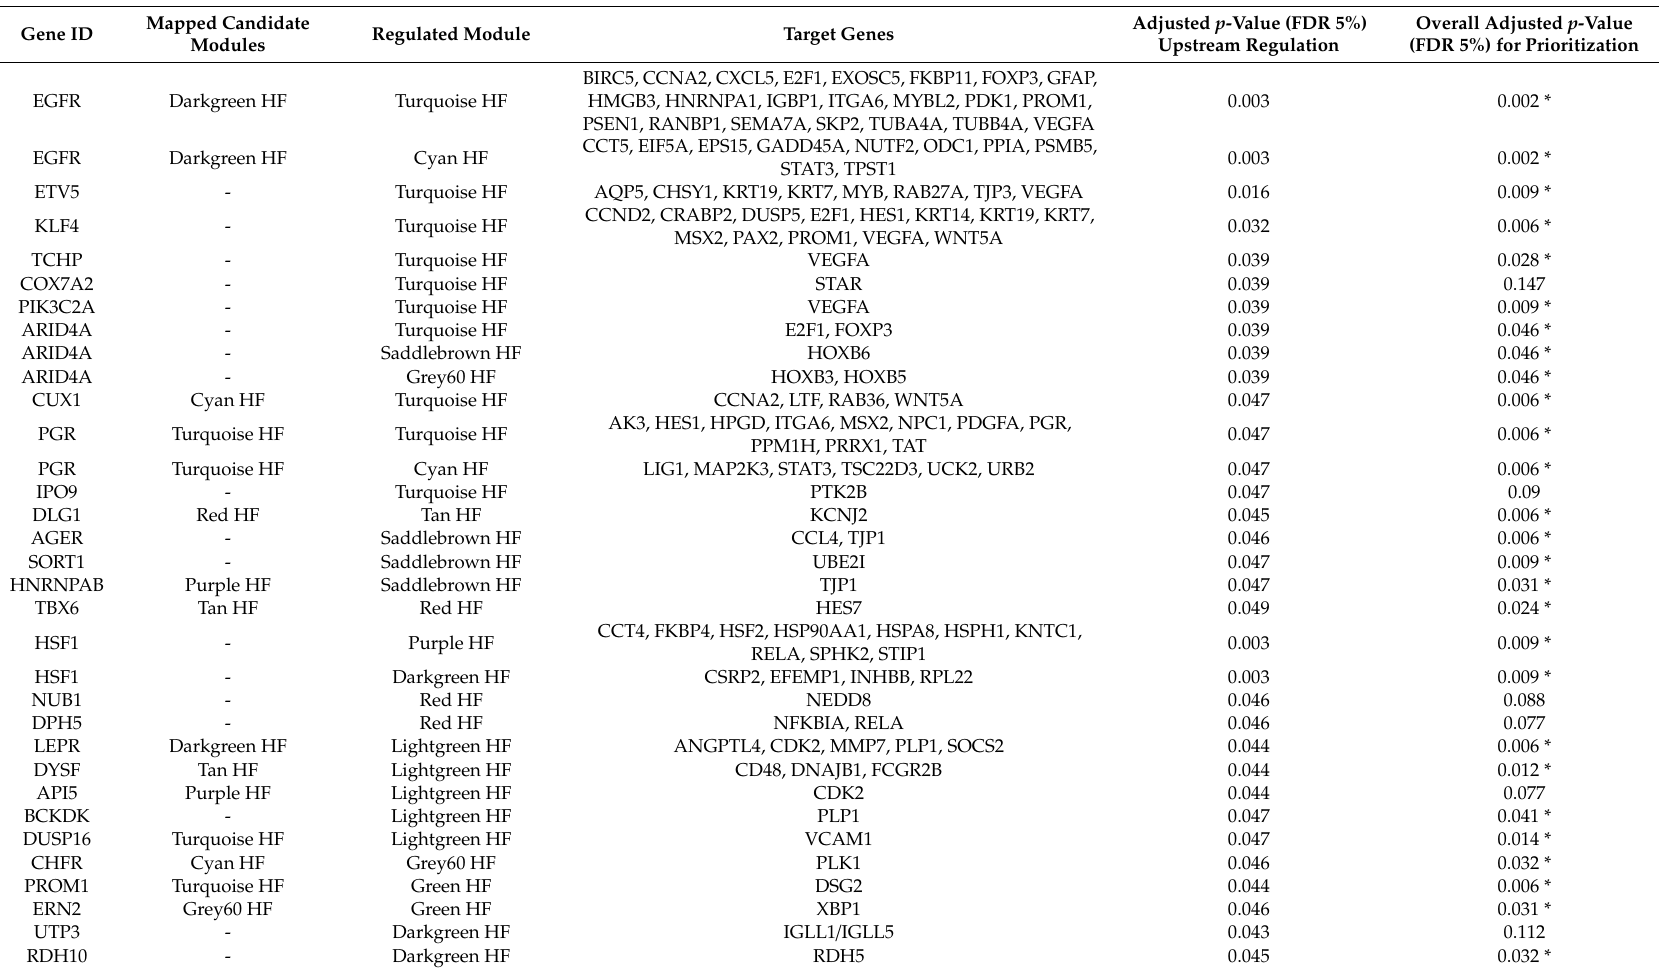
Table 3. Prioritization result for the significant upstream regulators, harboring functional candidate variants, from di ff erentially co-expressed modules between high-fertile (HF) and sub-fertile (SF)